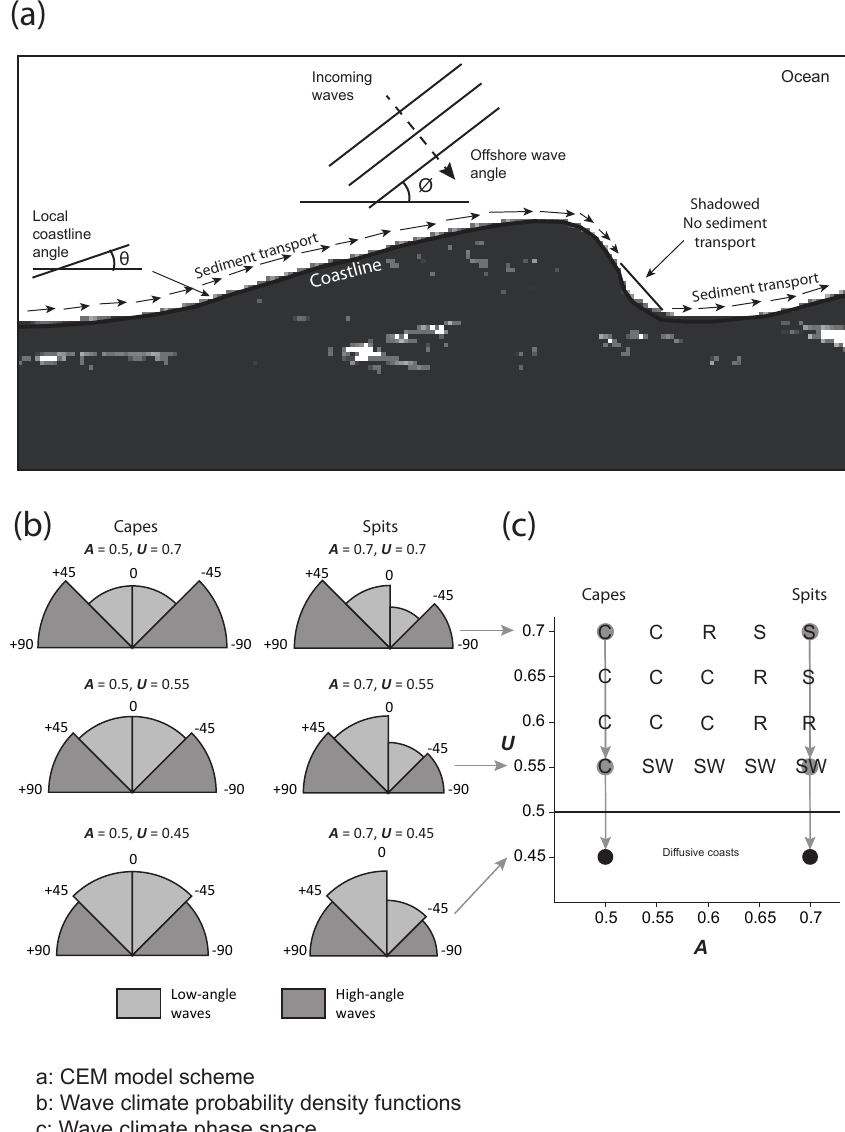
Figure 2. (a) The CEM model scheme. The coastline is discretized into cells. Local shoreline angles, θ , at each cell are calculated according to the schema outlined by Ashton and Murray (2006a). Sediment transport is determined by the effective wave angle (Ø– θ ). Arrows indicate net flux direction under waves incoming from the left; arrow lengths qualitatively indicate the flux. Sand is not transported through cells which are in shadow for a particular wave. Barrier width is maintained by a simple overwash scheme described by Ashton and Murray (2006a). (b) Rose diagrams of the four-bin probability density functions for wave climates used in the modelling, based on parameters U and A . (c) Wave climate trajectories used in the simulations defined by the U and A phase space, after Ashton and Murray (2006a). Wave climate asymmetry is defined by A ; U defines the proportion of offshore high-angle waves ( > 45 ◦ ). C: cuspate capes; R: recurved, connected spits; S: flying spits; SW: large-scale sand